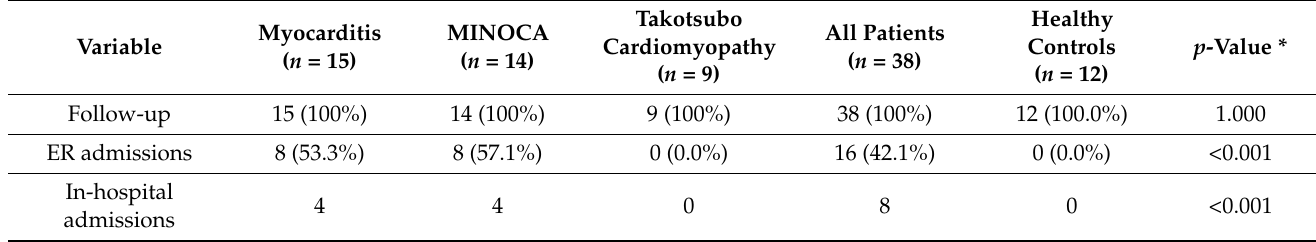
Table 5. Follow-up